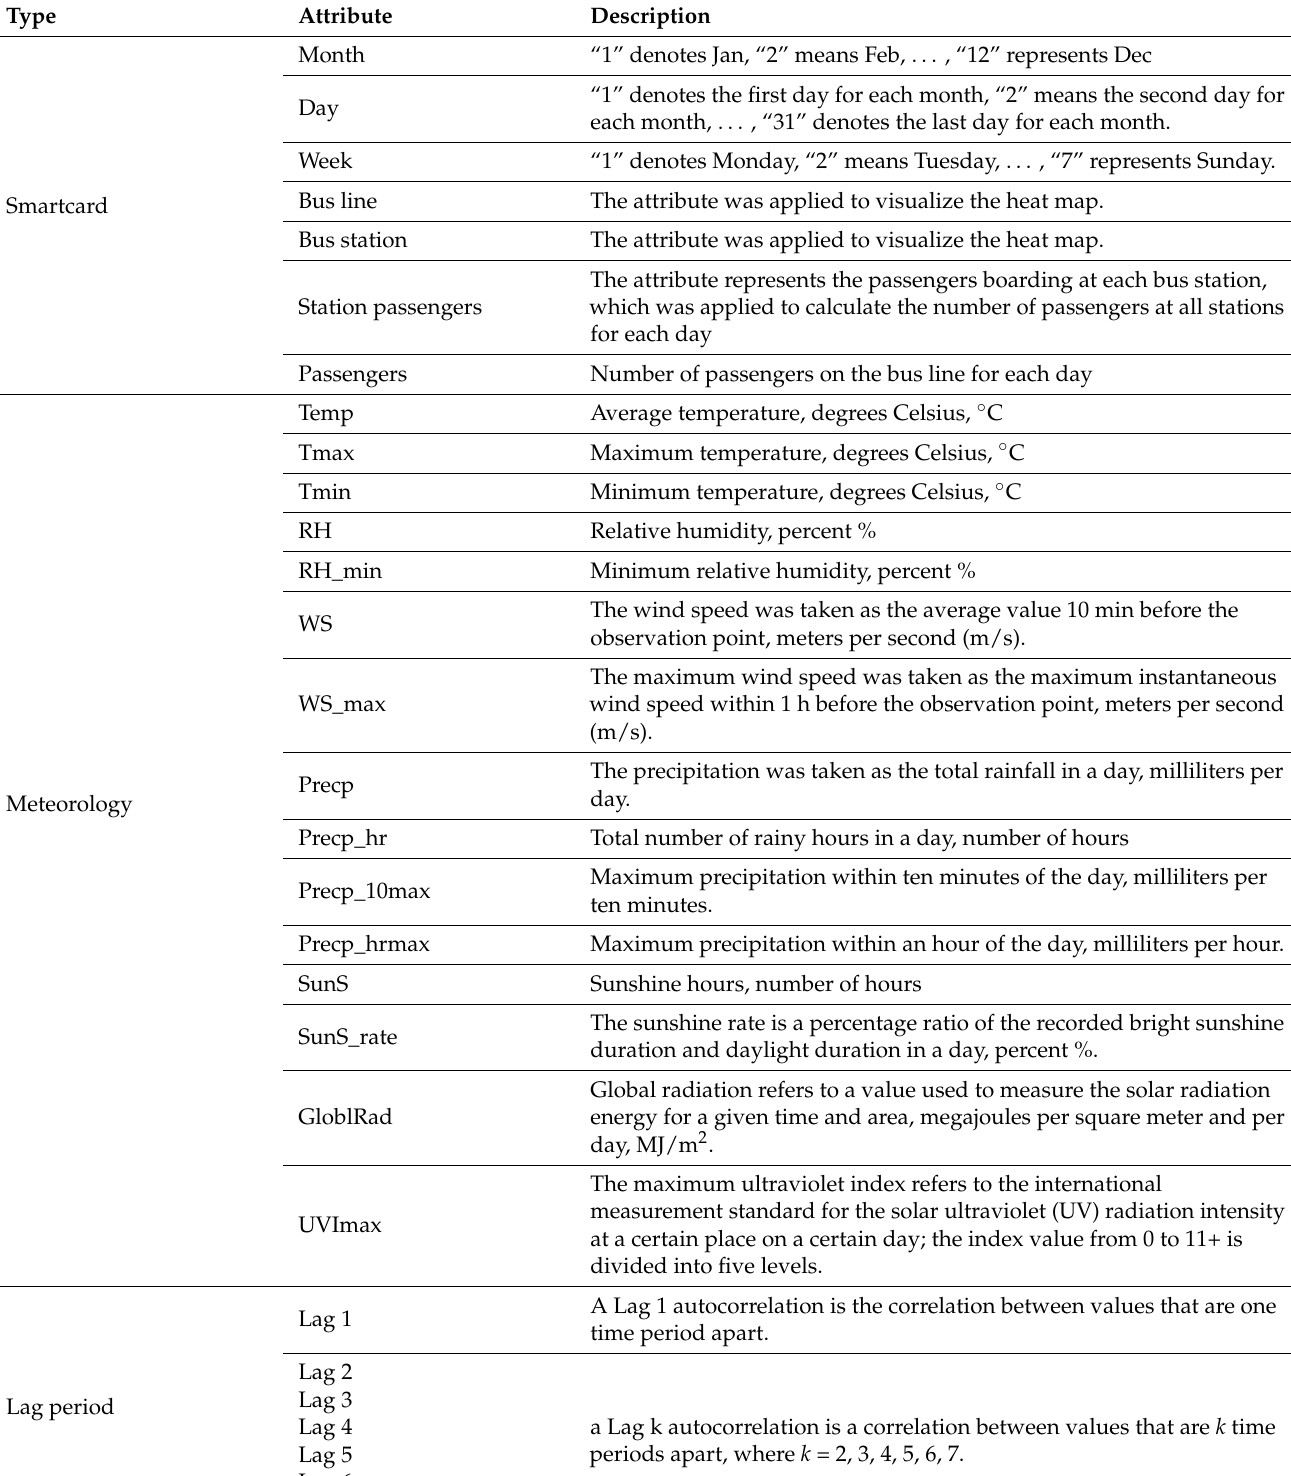
Table 2. Attributes used in this